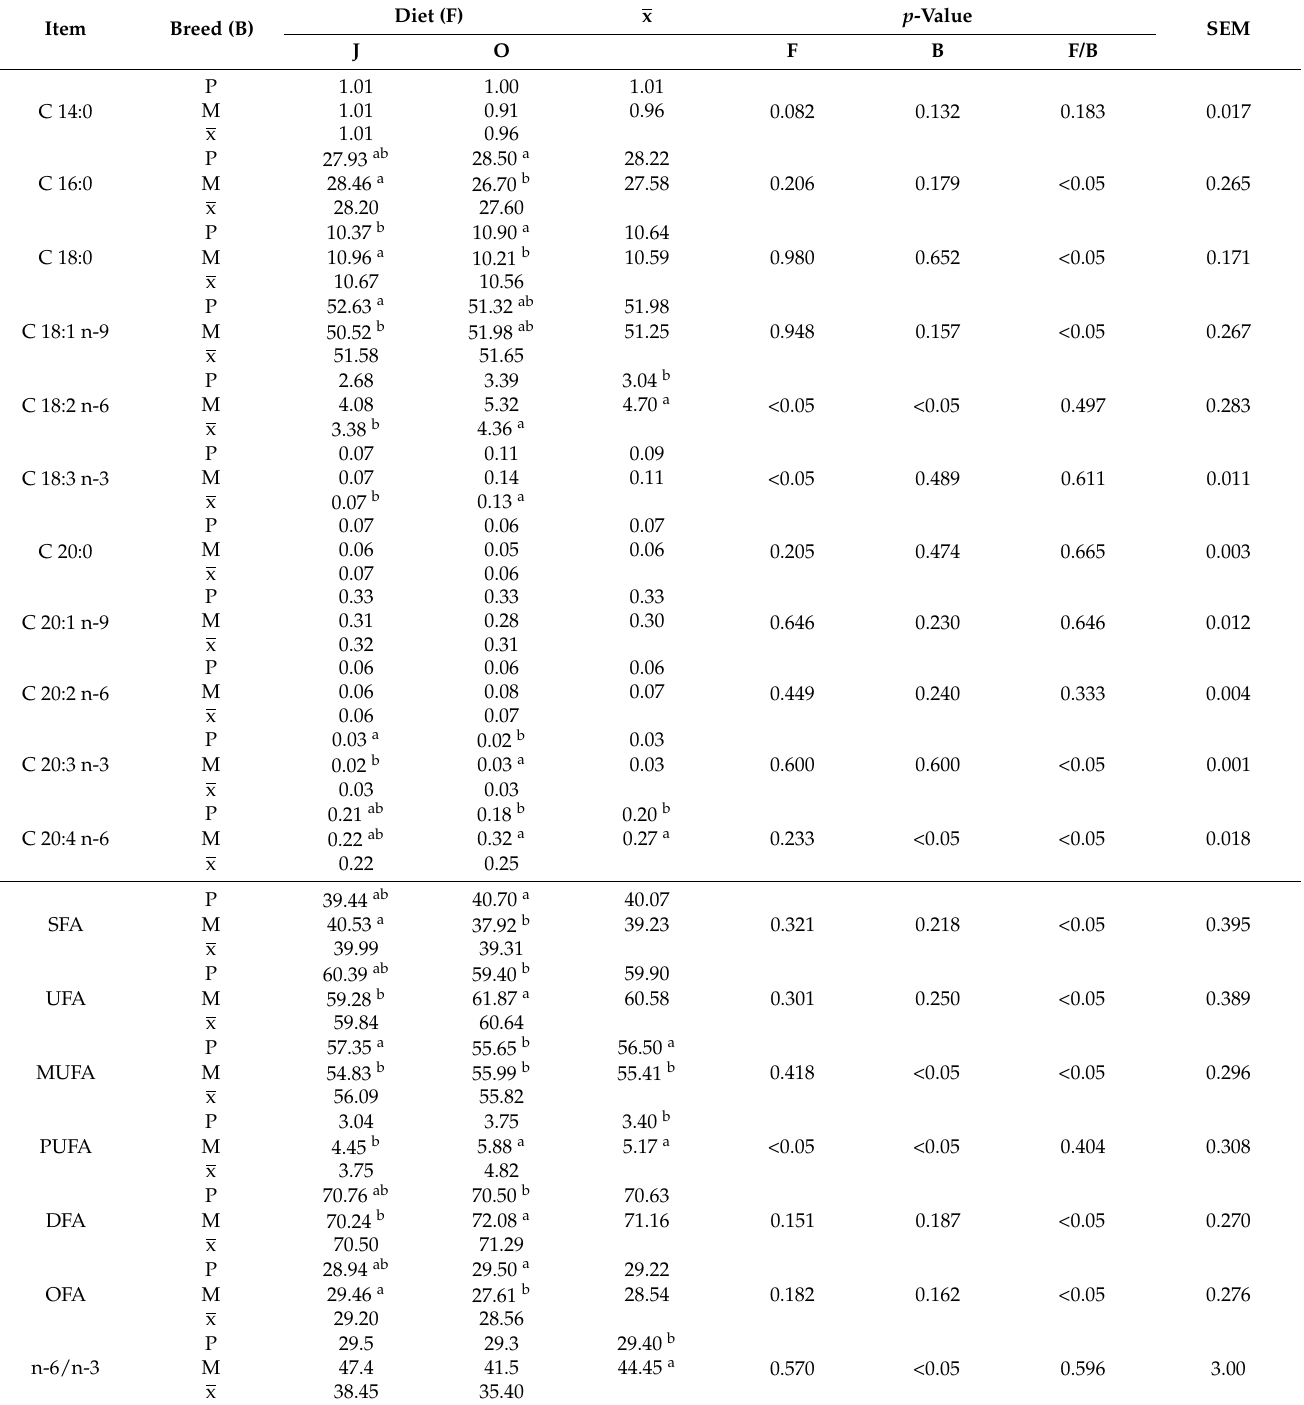
Table 7. Fatty acid profile (% total FA) of longissimus lumborum